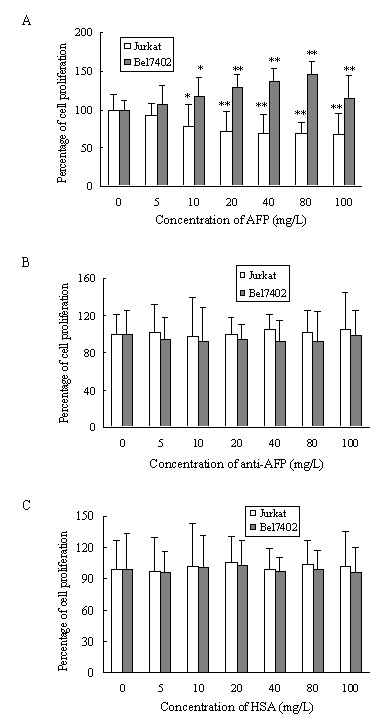
The effects of different concentrations of AFP on the growth of cells. The viability of Jurkat and Bel 7402 cells were observed after treated with different concentrations (5, 10, 20, 40, 80 or 100 mg/L) of either AFP (A), anti-AFP antibody (B) or HSA (C) for 60 h at 37°C in a humidified atmosphere of 5% CO2. *P < 0.05 and **P < 0.01 vs corresponding to normal control (0 mg/L) analyzed by t-test. Data were representative of an experiment that was repeated three times presented as mean ± SD of 12 samples.